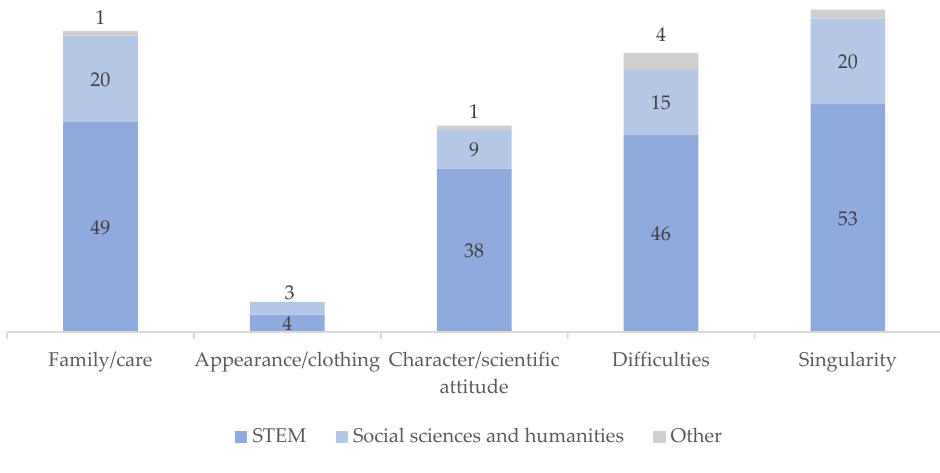
Figure 4. Presence of stereotypes, by knowledge area.